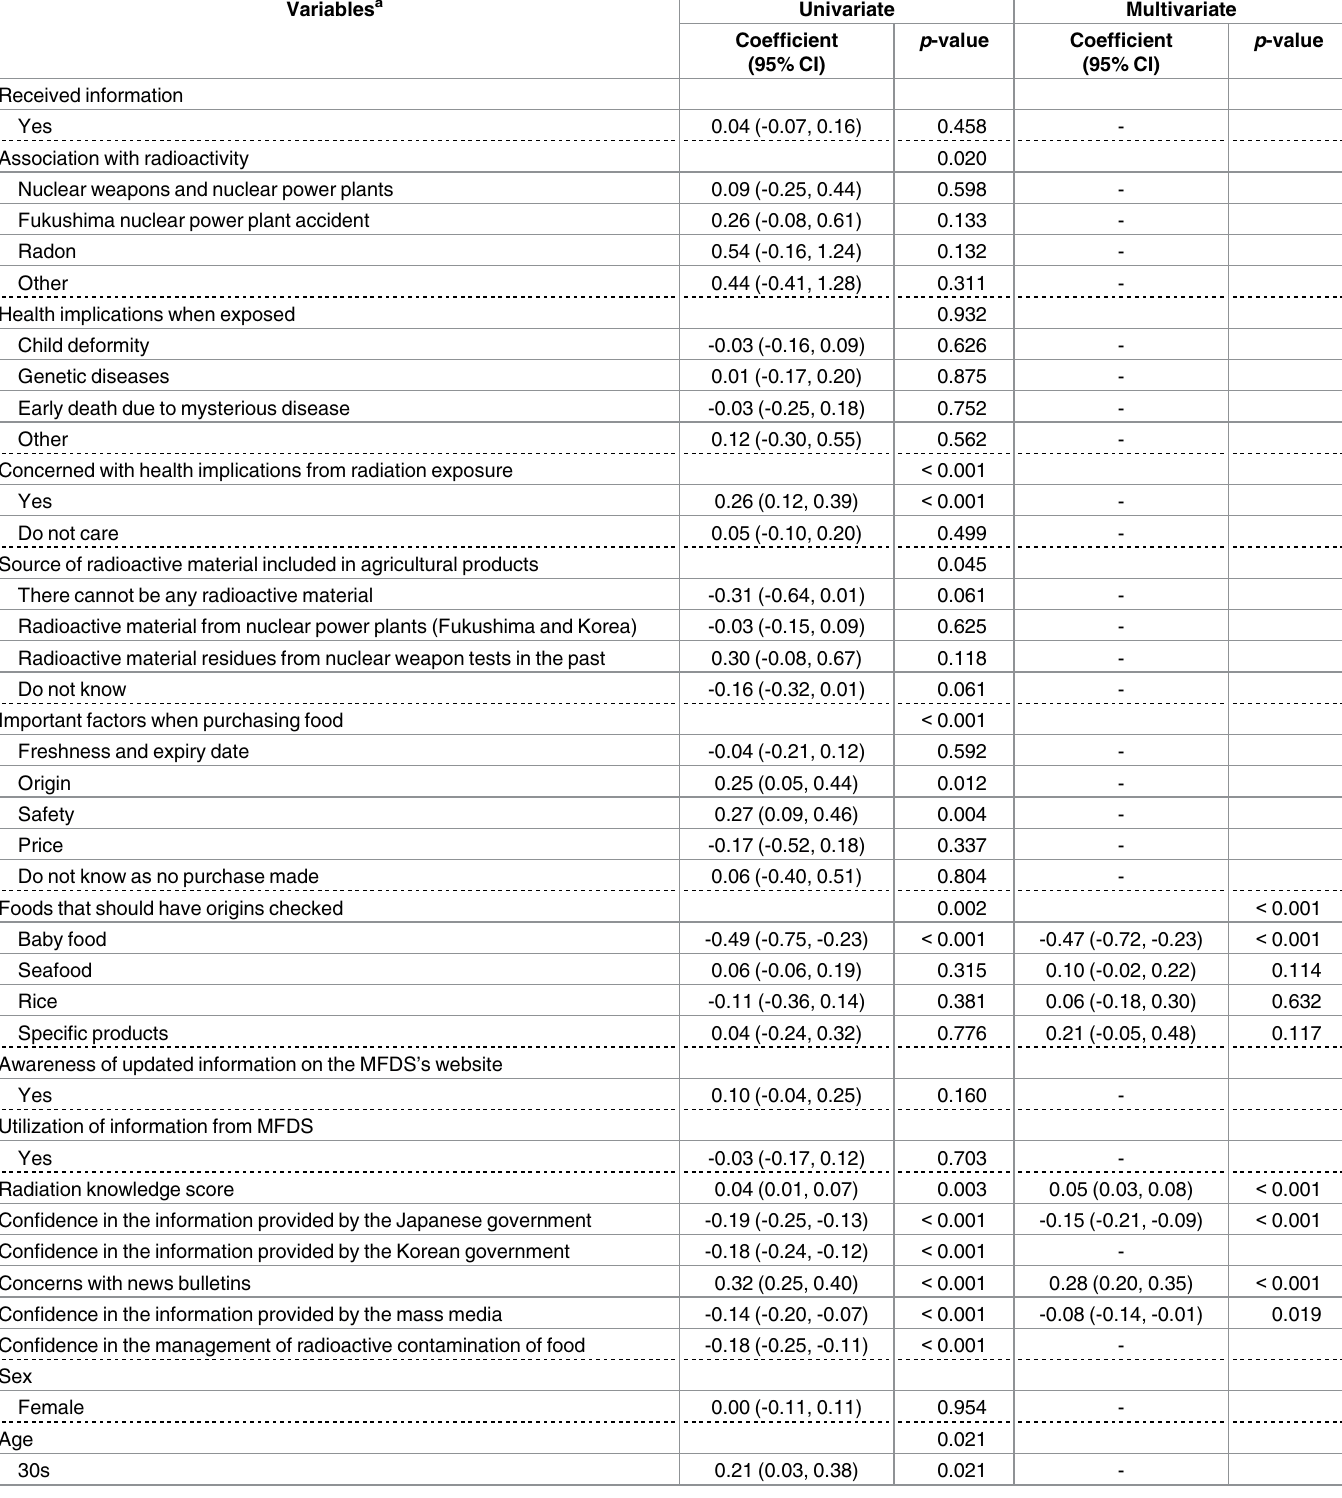
Table 7. Factors associated with agreement with the current import restraintsof Japanese